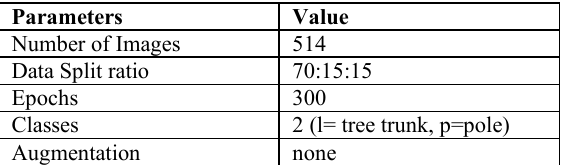
Table 2: Some Experimental parameters used for YOLOv5 algorithm